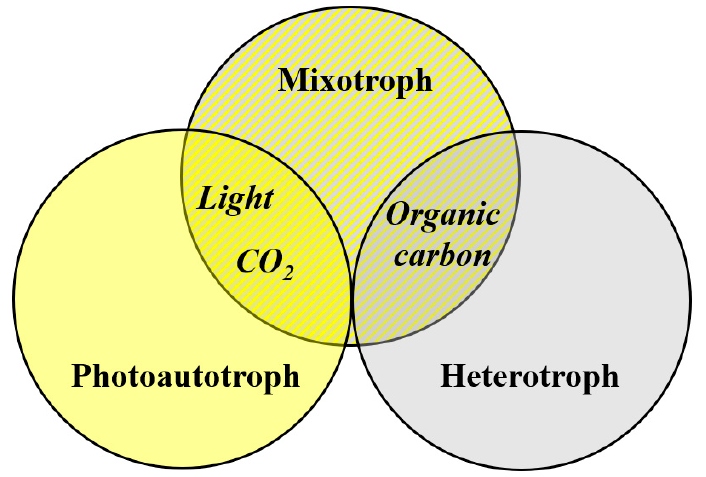
Figure 1. Energy and carbon sources of microalgae.